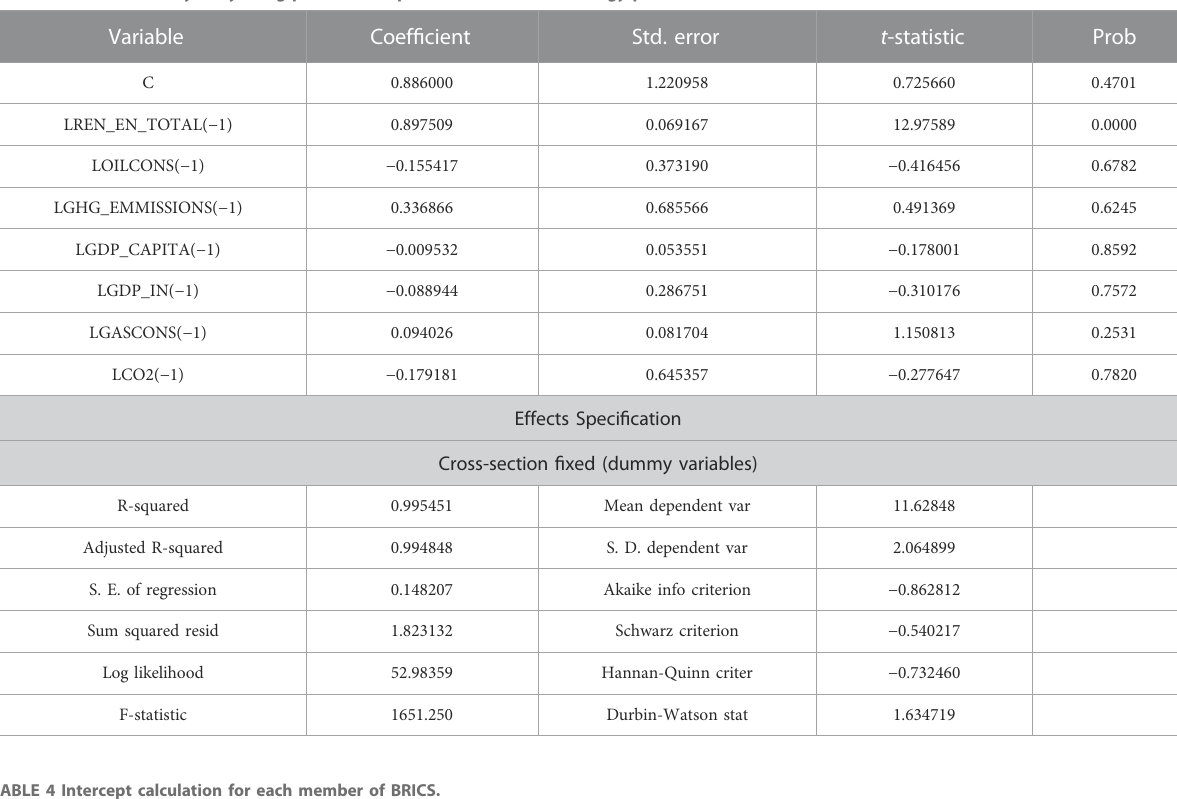
TABLE 3 Panel data analysis by using panel least squares and renewable energy production.